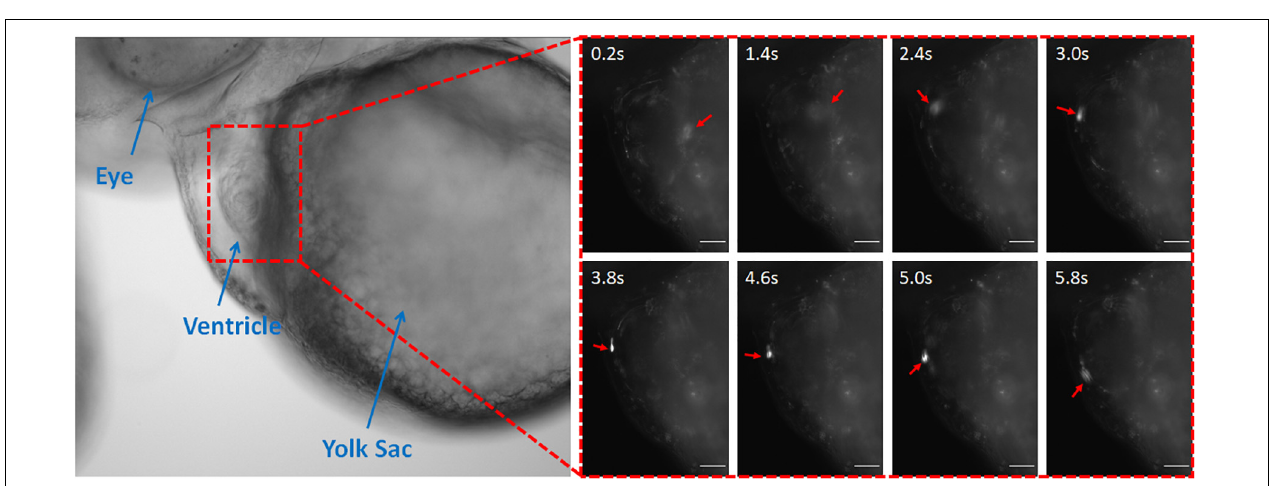
FIGURE 3 | Coumarin-6 Nanoparticles Rolling on Endocardium. Representative stills showing nanoparticles flowing through the cardiac chambers. Arrows indicate injected nanoparticle. All scale bars represent 100 µ